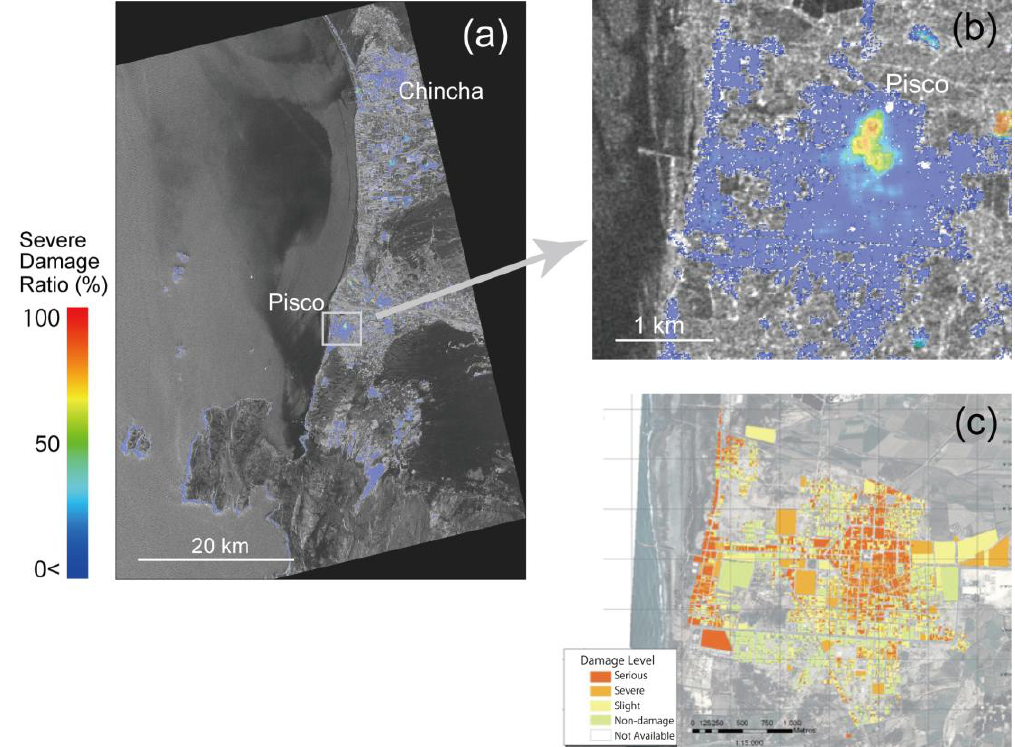
Figure 13. Distribution of severe damage ratios (average values) estimated from an integration of PALSAR images and seismic intensity information, and comparison with damage study data. (a) All areas of image. (b) Close up of Pisco area. (c) Building damage survey data in Pisco